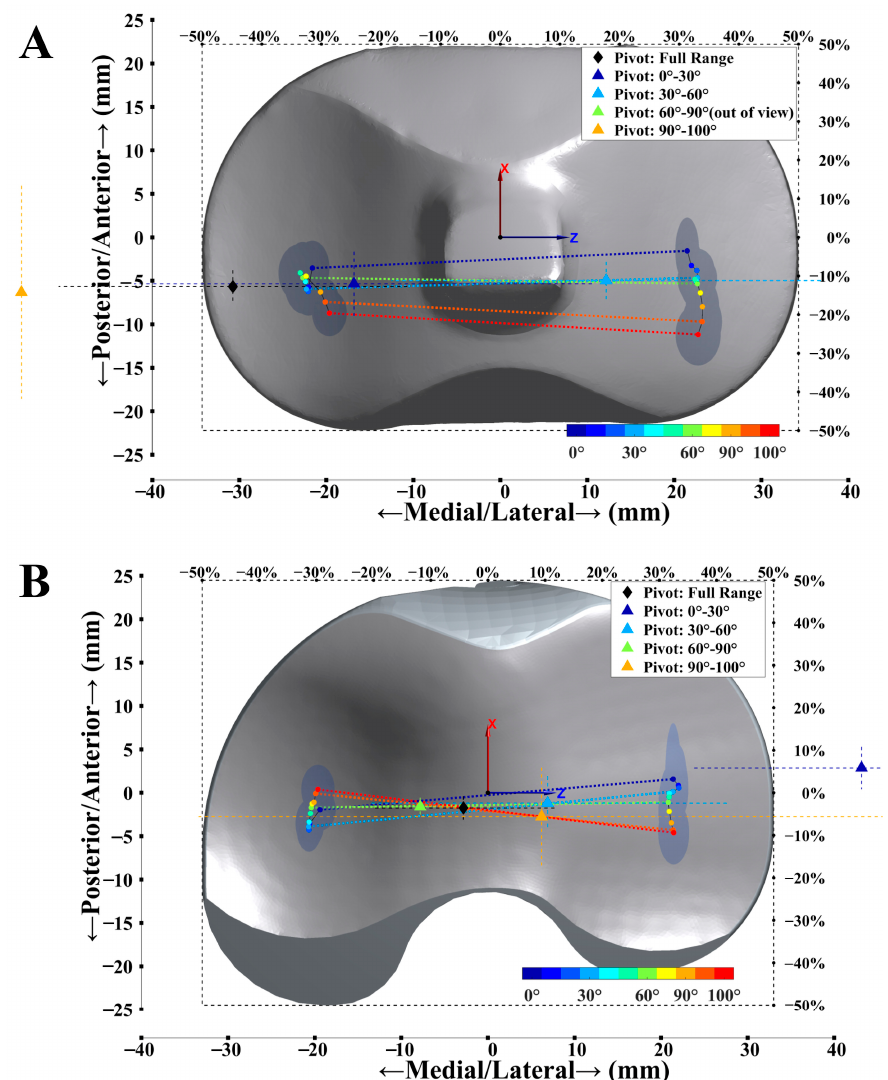
Figure 3. Locations of medial and lateral condylar contact points of PS-TKA ( A ) and MP-TKA ( B ) were shown on the right tibial polyethylene insertions as viewed from above during lunge. The origin was defined as the center of tibial insertions. Colored dots from blue to red represented the mean contact points in different flexion angles during the lunge. The dark blue area represented the ± 1 standard deviation in medial/lateral and anterior/posterior directions. The black diamond showed the pivot point during full range lunge. The colored triangles showed the pivot point of lunge in the phase of low flexion (0°–30°), pre-middle flexion (30°–60°), post-middle flexion (60°–90°) and high flexion (90°–100°). The error bars of pivot points in the x -axis and the z -axis were illustrated with dot lines. The standard deviation of the pivot point of PS-TKA at high flexion in the z -axis was too large to show in the figure. Please refer to Table 3. MP: medial-pivot. PS: posterior-stabilized. TKA: total knee arthroplasty.